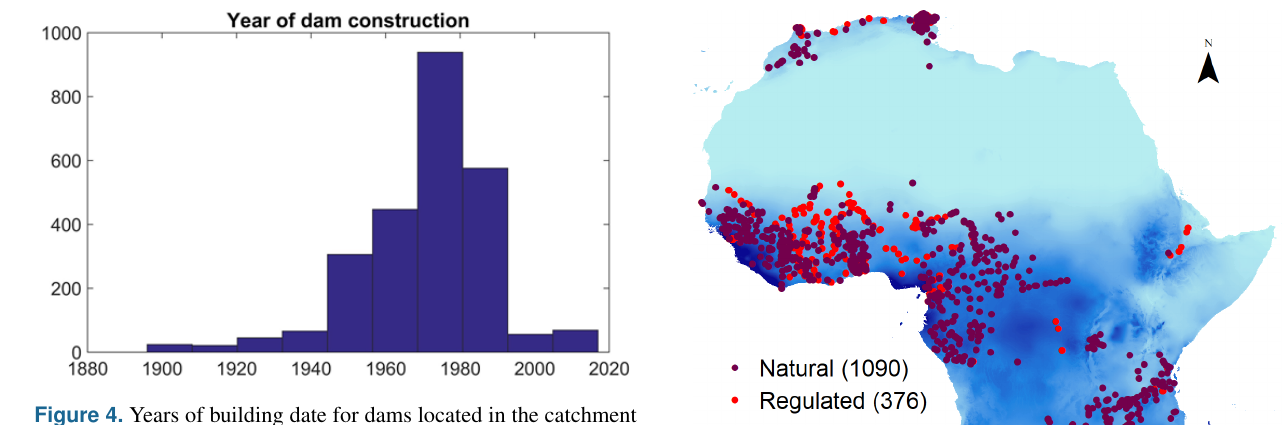
Figure 4. Years of building date for dams located in the catchment database (data from the Global Reservoir and Dam Database v1.3).